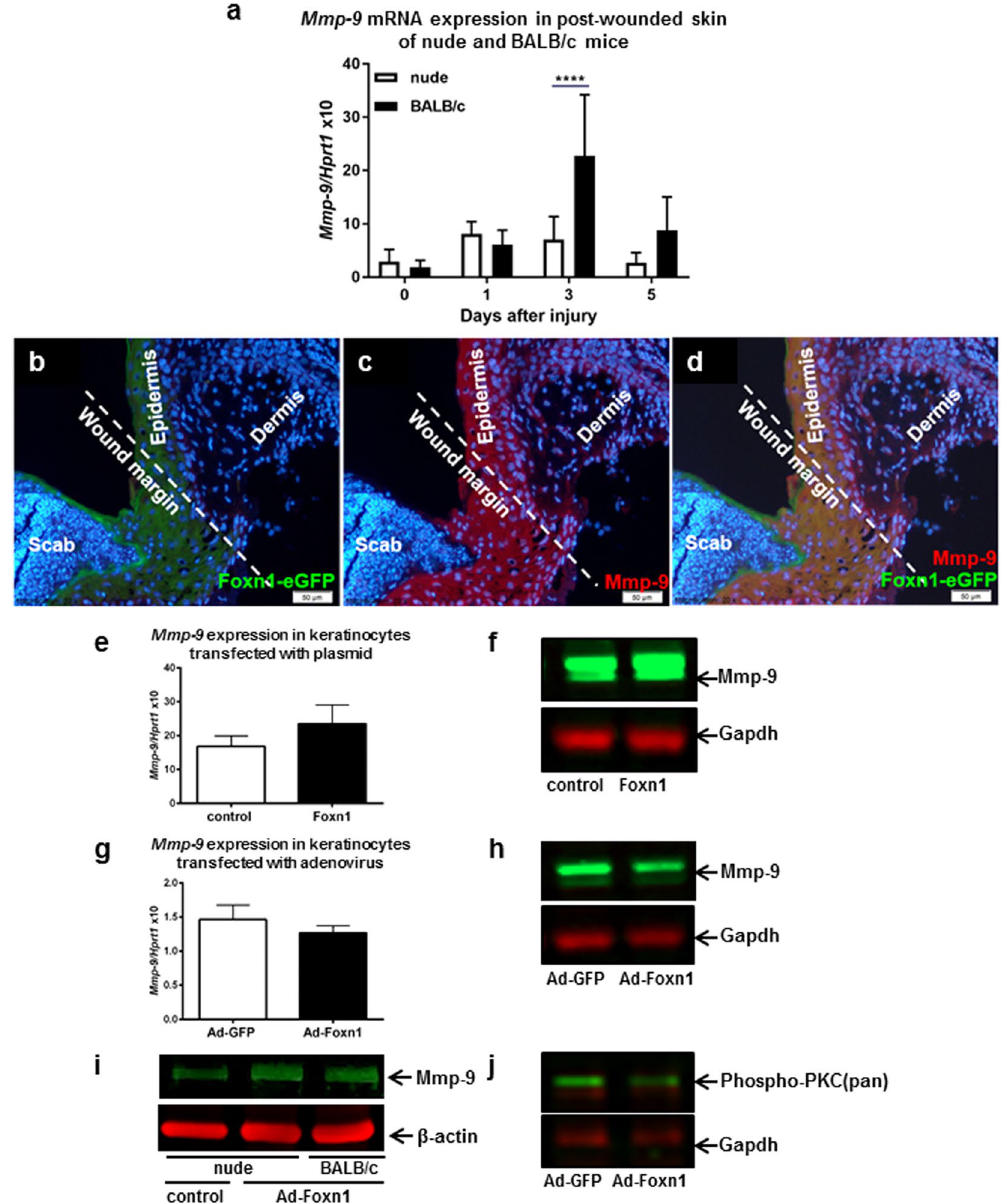
Figure 1. Mmp-9 is expressed in mice injured skin tissues ( a–d ) and in keratinocytes ( e–j ). Mmp-9 mRNA expression in the skin of nude (Hsd:Athymic Nude-Foxn1 nu ) and BALB/c mice at post-wounding days 1, 3, and 5 ( a ). Immunofluorescent detection of Foxn1-eGFP ( b ) and Mmp-9 ( c ) and co-localization of Foxn1-eGFP and Mmp-9 signals ( d ) in the skin of Foxn1::Egfp mice at day 2 after injury. Mmp-9 mRNA ( e , g ) and corresponding Mmp-9 protein ( f , h ) expression in keratinocytes isolated from B6 (E-H, J), BALB/c ( i ) and nude ( i ) mice and co-cultured with dermal fibroblasts (DFs). Keratinocytes were transfected with Foxn1-containing plasmid ( e , f ) or adenovirus (Ad-Foxn1; g–j ) and cultured for 48 h. Control cultures were transfected with a vector expressing GFP alone. Representative Western blot analysis of phospho-PKC (pan) protein expression in Ad-Foxn1- or Ad- GFP-transfected keratinocytes co-cultured with DFs ( j ). Full-length blots and densitometric analysis are presented in Supplementary Fig. S1. ( b–d ) Scale bar 50 µ m. Values are the mean ± SD, **** p < 0.0001. ( a ) Modified from: Scarless skin wound healing in FOXN1-deficient (nude) mice is associated with distinctive matrix metalloproteinase expression. Gawronska-Kozak B., Matrix Biol 2011;30(4):290–300 12 , with permission of